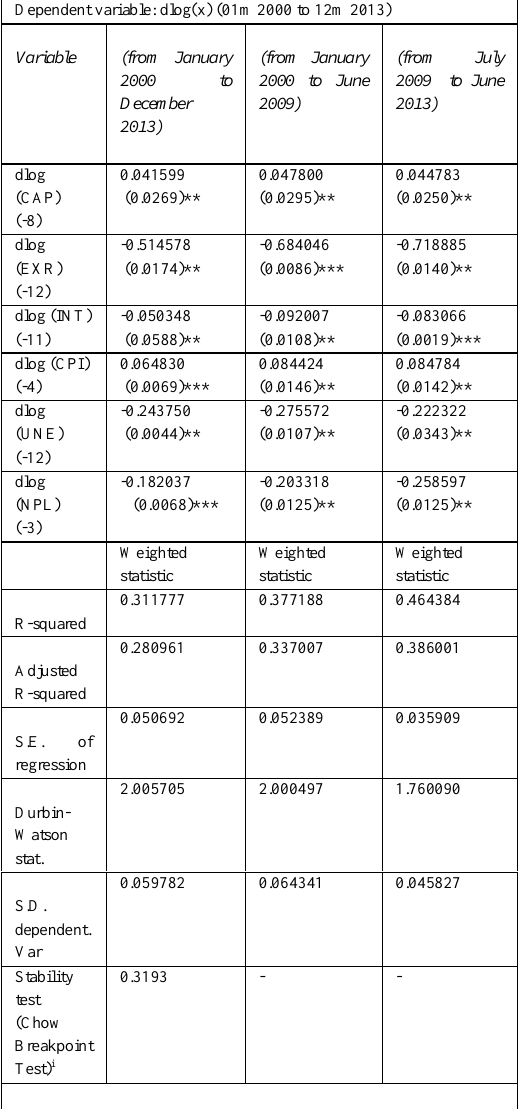
Table 2: OLS – Croatia Dependent variable: dlog(x) (01m 2000 to 12m